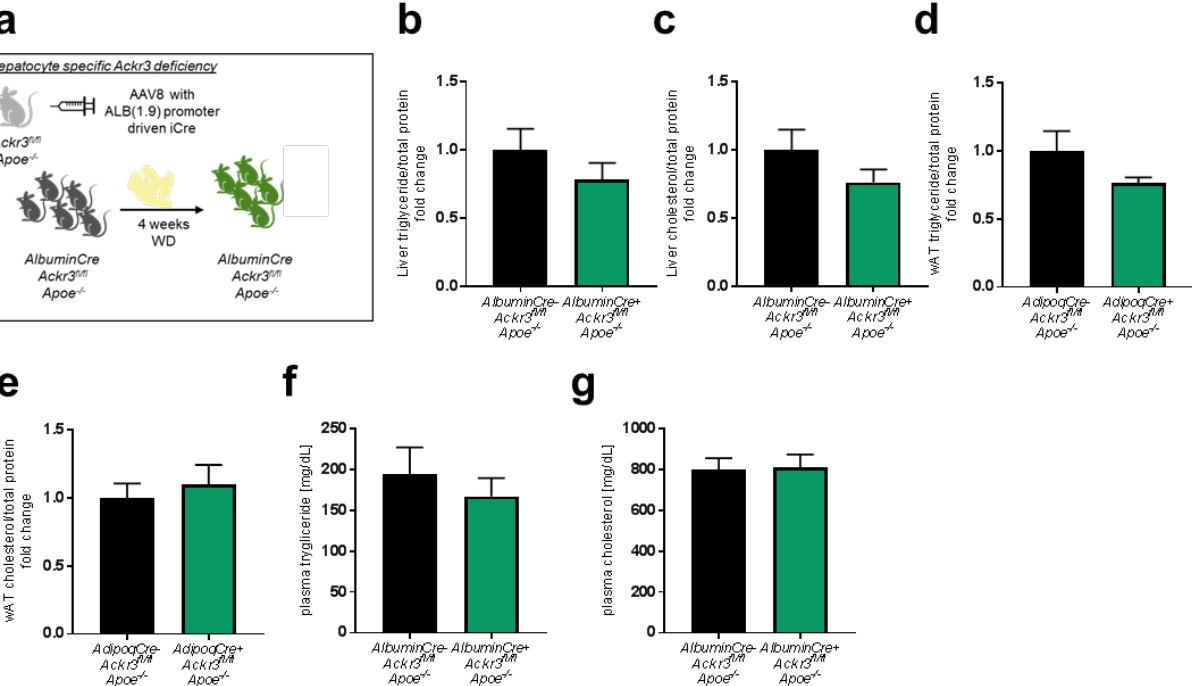
Figure 4. ACKR3 deficiency in hepatocytes does not influence hepatic lipid levels. ( a ). Schematic representation of the experimental setup. ( b , c ). Total triglyceride ( b , n = 11 – 12) and total cholesterol ( c , n = 11 – 12) levels in the liver. ( d , e ). Total triglyceride ( d , n = 9 – 10) and total cholesterol ( e , n = 9 – 10) content in wAT samples normalized to total protein levels. ( f , g ). Plasma levels of total triglyceride ( f , n = 10 – 11) and total cholesterol ( g , n = 10 – 11).